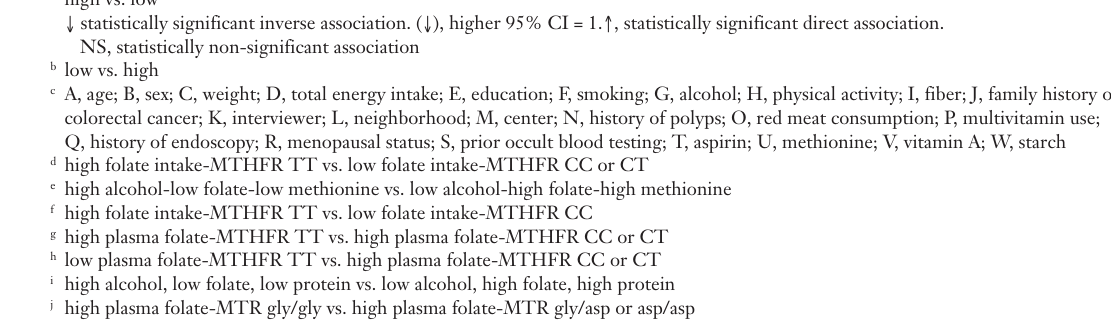
↓ statistically significant inverse association. ( ↓ ), higher 95% CI = 1. ↑ , statistically significant direct association. NS, statistically non-significant association b low vs. high c A, age; B, sex; C, weight; D, total energy intake; E, education; F, smoking; G, alcohol; H, physical activity; I, fiber; J, family history of colorectal cancer; K, interviewer; L, neighborhood; M, center; N, history of polyps; O, red meat consumption; P, multivitamin use; Q, history of endoscopy; R, menopausal status; S, prior occult blood testing; T, aspirin; U, methionine; V, vitamin A; W,